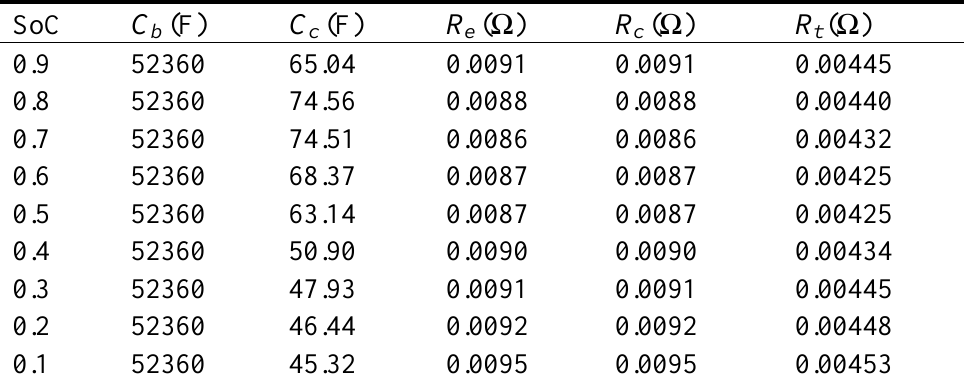
Table 1. Initial parameters of the battery model.